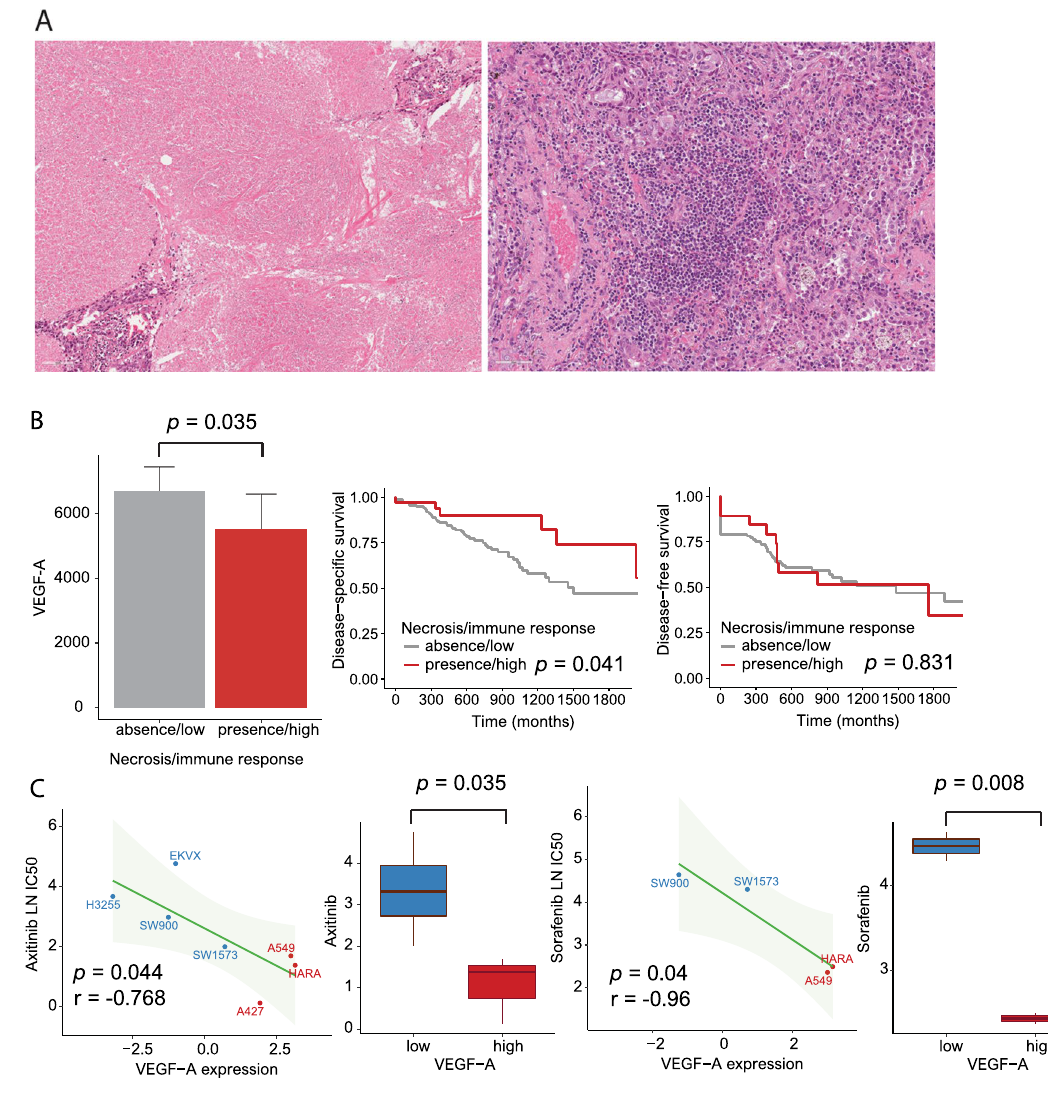
Figure 5. ( A ) Representative histological features: coagulative necrosis (left) and tumor-infiltrating lymphocytes (TILs) (right). ( B ) Bar plots of VEGF-A according to necrosis (coagulative necrosis)/immune response ↑ (elevated TILs) ( p = 0.035) (left) and disease-specific survival/disease-free survival according to necrosis/immune response ↑ ( p = 0.041 and 0.831, respectively). ( C ) Pearson’s correlations and boxplots showing the natural log half-maximal inhibitory concentration (LN IC50) of axitinib [r = − 0.768, p = 0.044 (Pearson’s correlation) and 0.035 (Student’s t-test)] (left) and sorafenib [r = − 0.96, p = 0.04 (Pearson’s correlation) and 0.008 (Student’s t-test)]